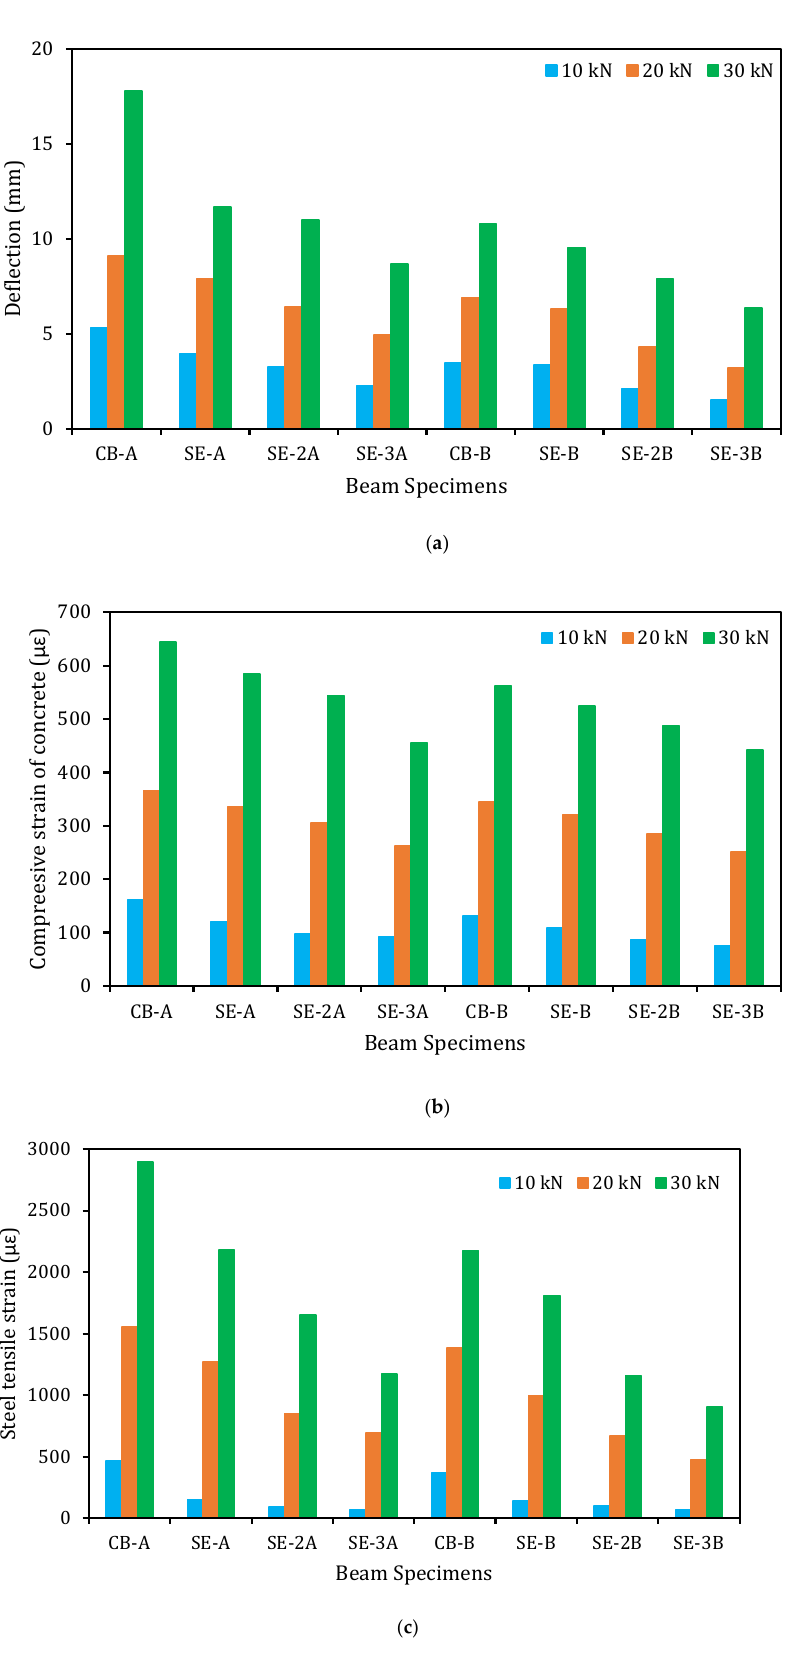
Figure 12. Reduced deflection, compressive, and tensile strains by E-SBR-CFRP fabrics at different loading. ( a ) reduced deflection; ( b ) reduced concrete compressive strains; ( c ) reduced steel rebar tensile strains